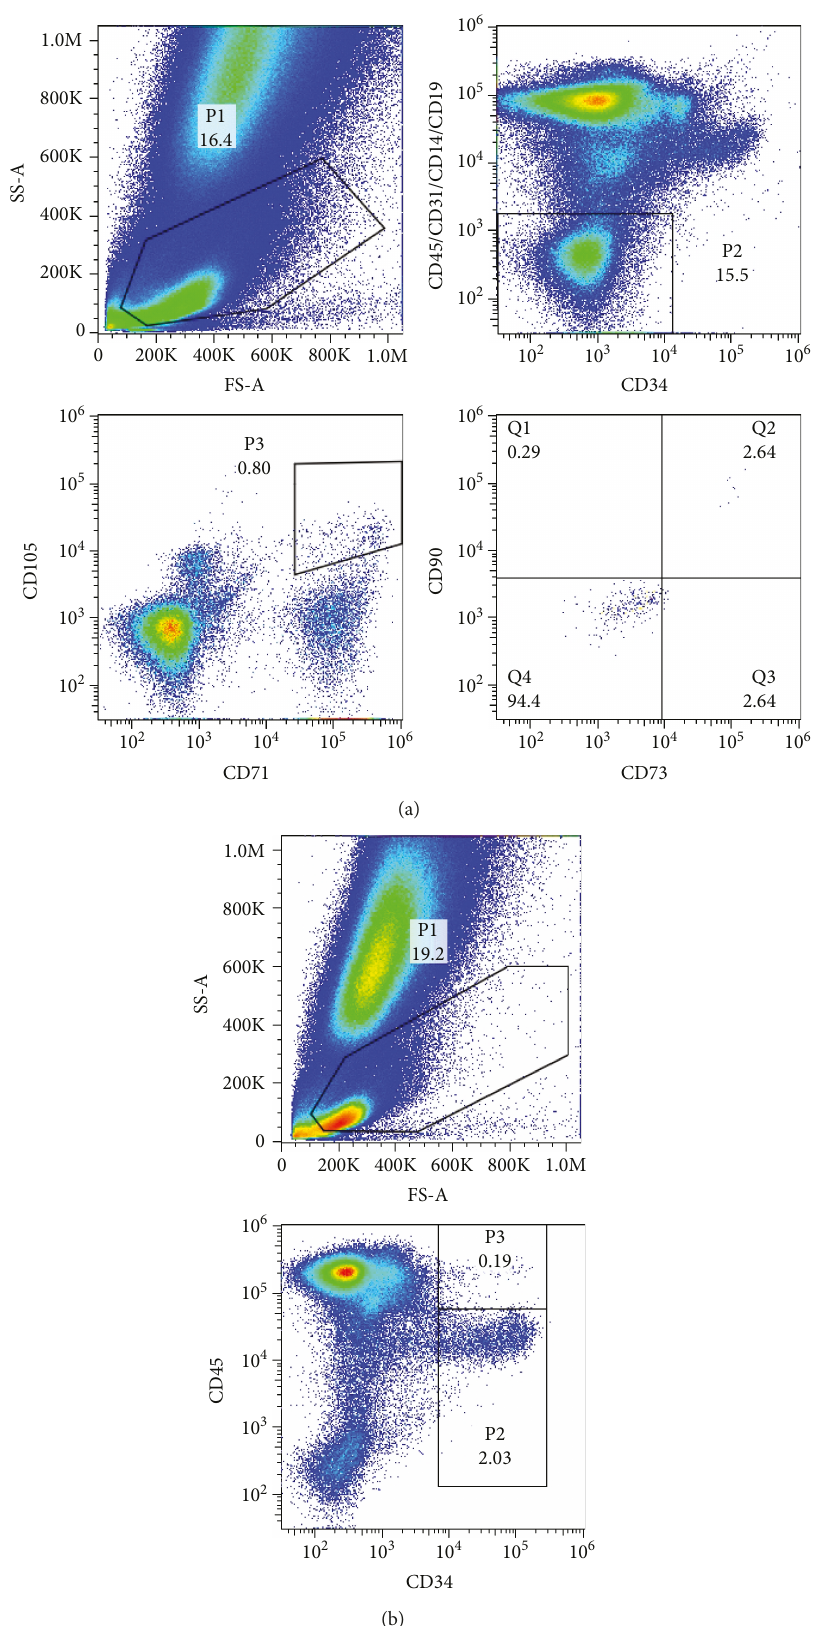
Figure 2: Representative cell surface antigen expression pro fi le of isolated BMCs analyzed by fl ow cytometry: (a) MSCs, (b)